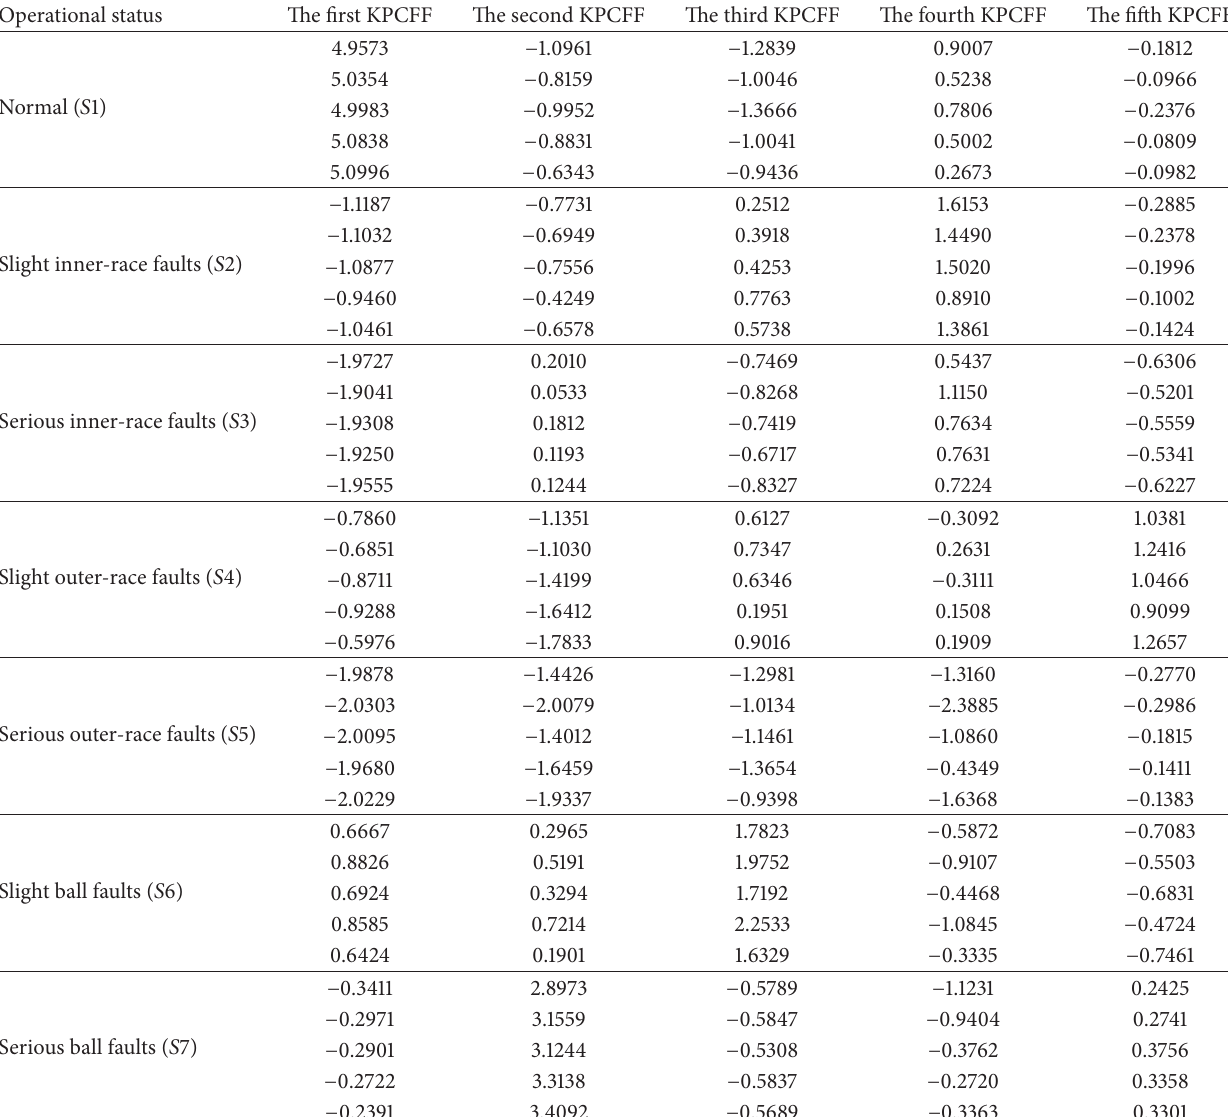
Table 4: Kernel Principle Component Fusion